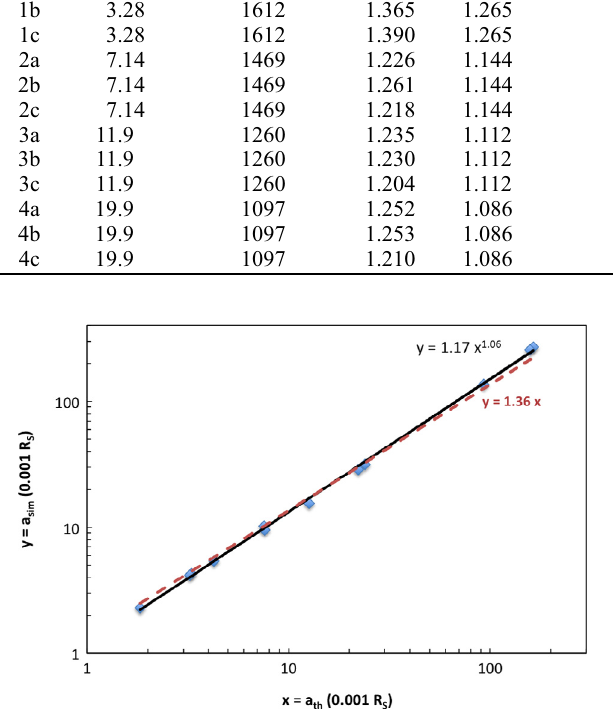
Fig. 4. Comparison of the simulated and the theoretical values of the foreshock parameter a . The solid line gives the power-law fit and the dashed red line the linear approximation between the quantities.